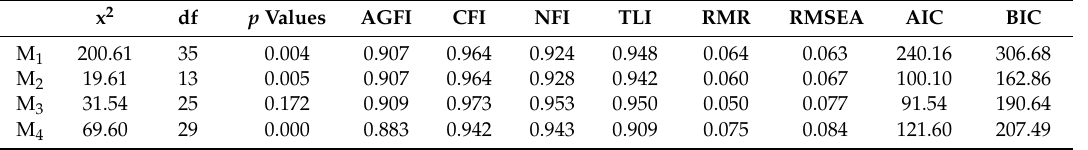
Table 3. Fit indices for the ATE from Confirmatory Factor Analysis.